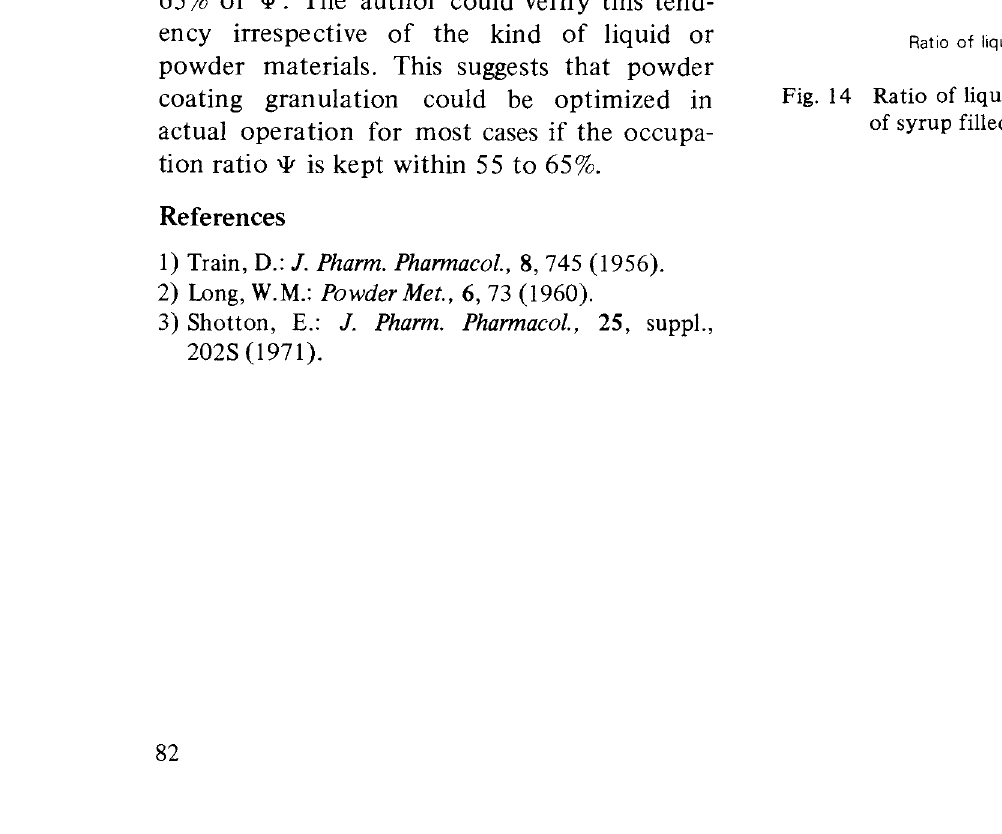
Fig. 14 Ratio of liquid to solid vs. occupation